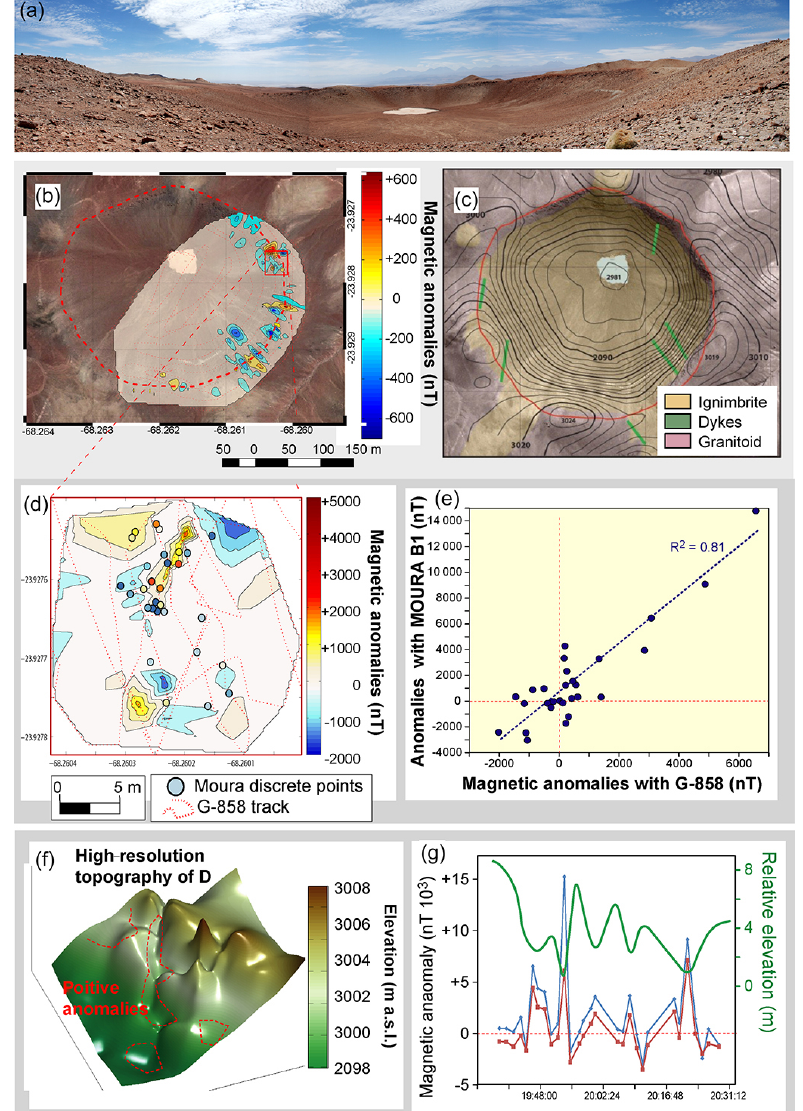
Figure 4. Magnetic and geological features of Monturaqui impact crater. (a) photo of the crater looking towards the north. (b) Track (red stippled line) and interpolated mapping grid of G-858. (c) Topography and exposed geological units. (d) Detailed mapping area at the northeastern crater rim with discrete magnetic data points of the MOURA on an interpolated magnetic map of G-858. (d) X – Y comparison of the MOURA sensor B1 with G-858 data. (f) Topography of the local mapping area (shown in d ) and areas with stronger positive anomalies at topographic lows marked in red. (g) Comparison of the MOURA B1 and B2 data and their local